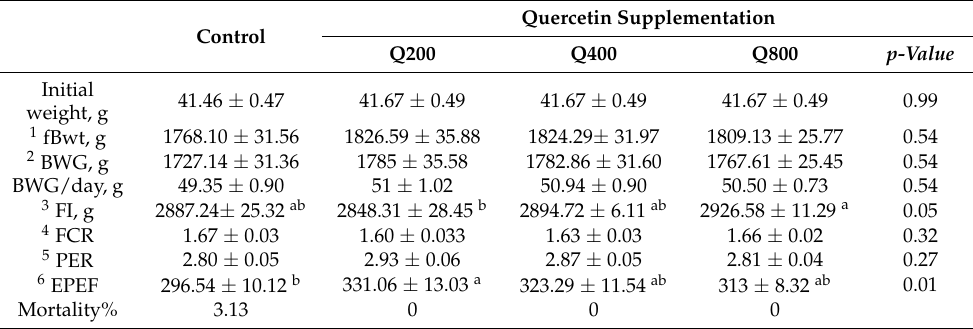
Table 5. Effect of dietary quercetin supplementation on growth performance and mortality rate of broilers. Quercetin Supplementation Control Q200 Q400 Q800